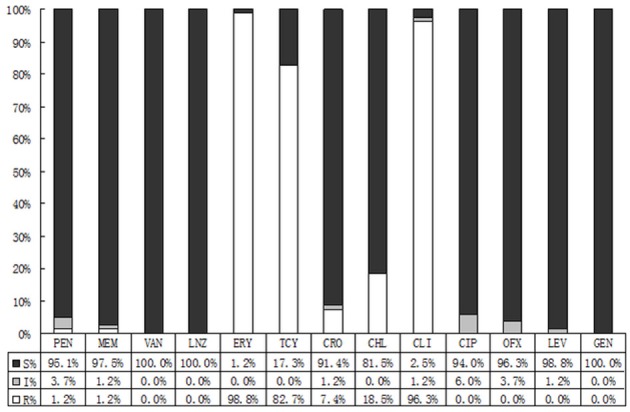
Results of sensitivity against Streptococci spp.antibiotics. S, Sensitive; I, Intermediate; R, Resistant; PEN, Penicillin; VAN, Vancomycin; LNZ, Linezolide; RIF, Rifampicin; ERY, Erythromycin; TCY, Tetracycline; CRO, Ceftriaxome; CLI, ClindamycinS; CIP, Ciprofloxacin; OFX, Ofloxacin; LEV, Levofloxacin.